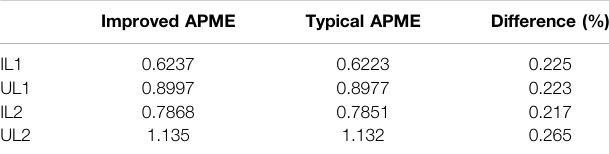
TABLE 2 | Voltage and current details on loads under operation condition I. Improved APME Typical APME